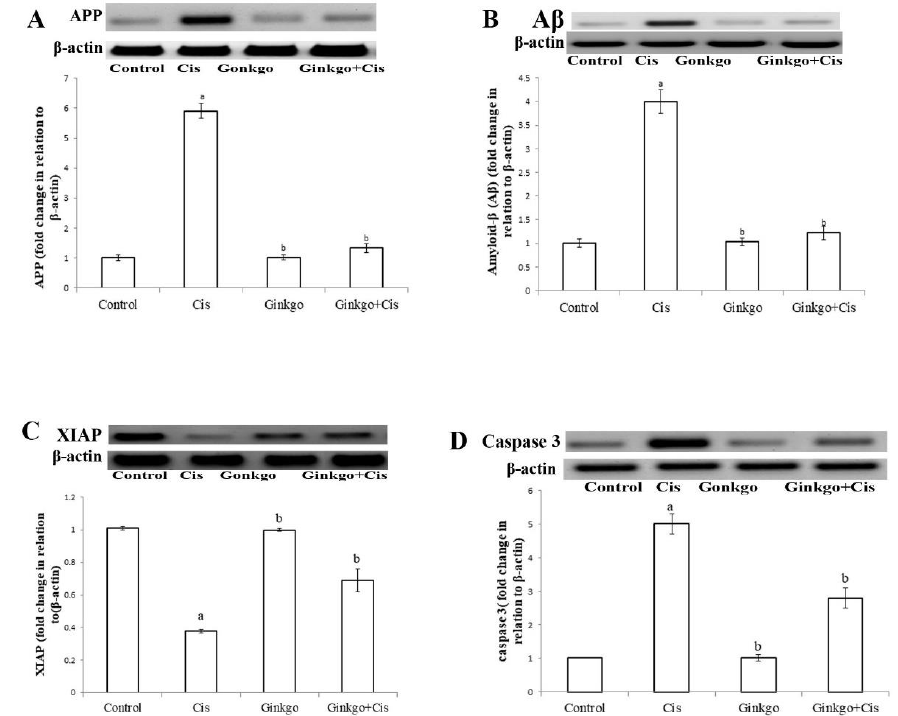
Figure 4. The changes of amyloid precursor protein (APP), Aβ, XIAP and caspase-3 in different groups. The effect of Cis, Ginkgo , and their combination on the expression levels of APP ( A ), Amyloid β (Aβ) ( B ), XIAP ( C ), caspase-3 ( D ) in rat brain tissues. Data present as mean ± SE ( n = 10). a indicates a significant difference compared to control group, b indicates a significant change compared to Cis group. a and b indicate statistical significance at p < 0.05 using ANOVA followed by Tukey–Kramer as a post ANOVA test.